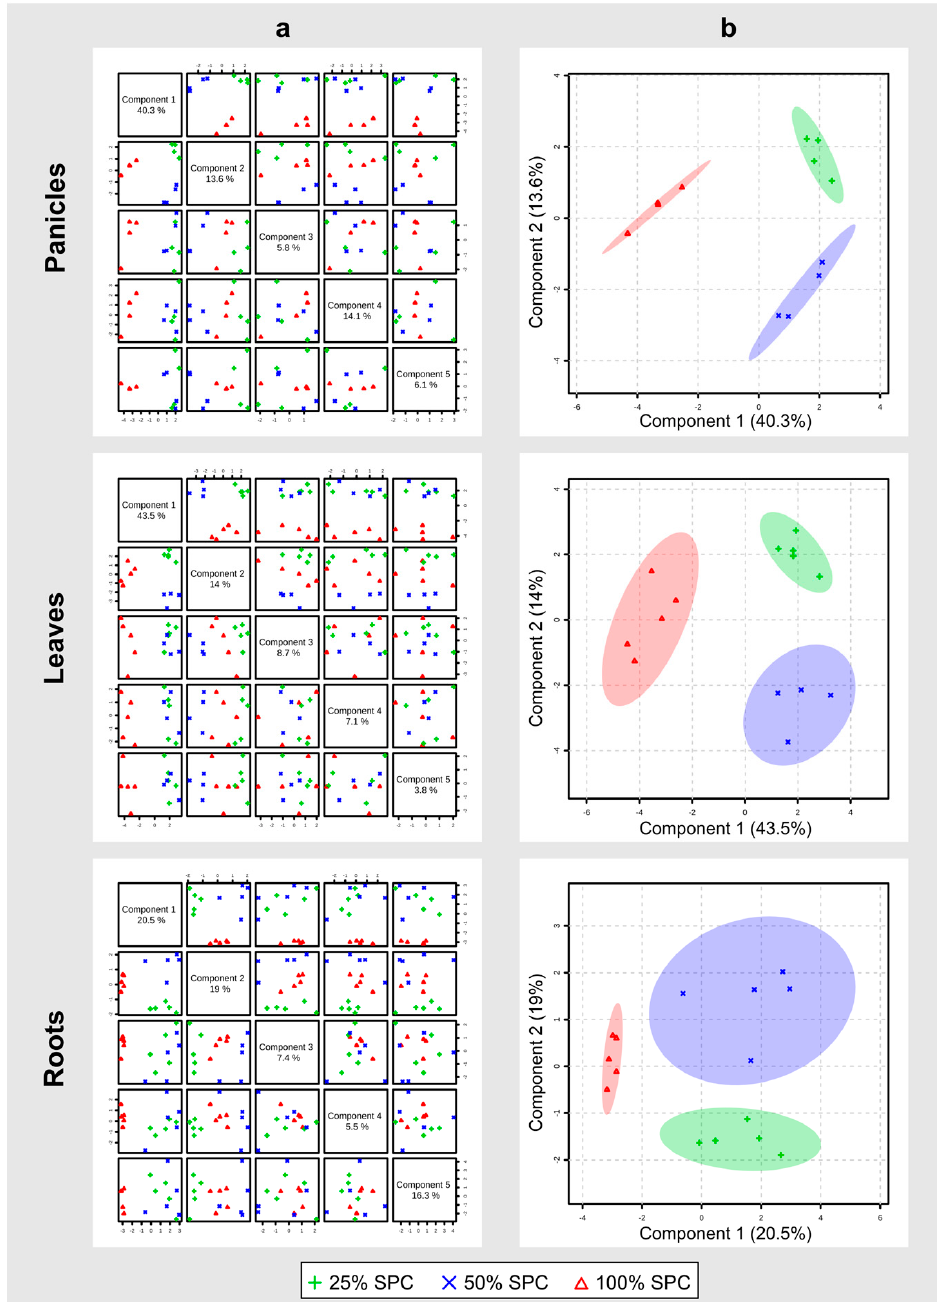
Figure 1. sPLS-DA overview plot showing the five components ( a ) and 2D score plots of PC1 and PC2 ( b ) for S. viridis panicles, leaves and roots submitted to three water treatments (100%—control, 50% and 25% SPC). In ( a ), X and Y axes vary from − 2 to 2 at regular intervals. In ( b ), the area around the points represents the 95% confidence interval.